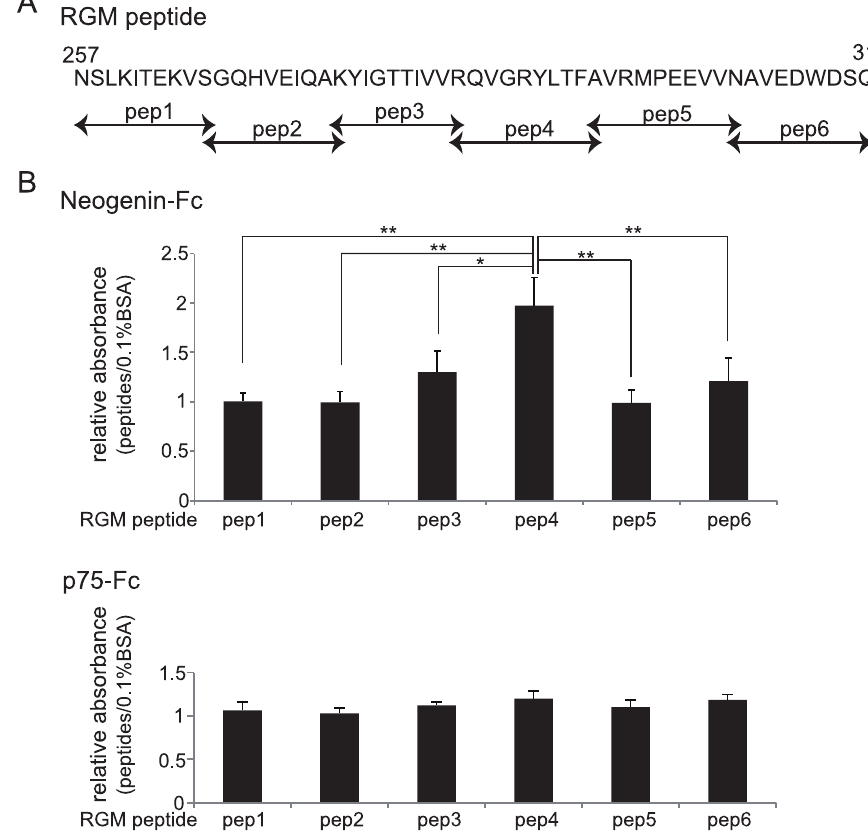
Figure 2. RGMa aa 284–293 are critical for the interaction with neogenin. (A) Sequence alignment of the synthesized RGMa peptide. Peptides 1–6 were designed within aa 257–310, which is the region required for the interaction between RGMa and neogenin as shown in Fig. 1. (B) RGMa peptide 4 (aa 284–293) directly binds to neogenin’s ECD. Relative binding of each RGMa peptide to ELISA plates coated with neogenin-ECD-Fc is shown. p75NTR-Fc was used as a control. Results (%) are shown as the mean 6 SEM of 3 independent experiments (** P , 0.01, * P , 0.05).